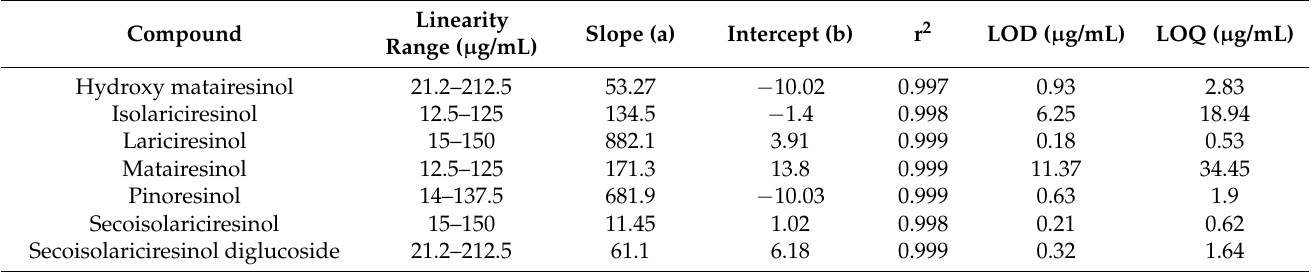
Table 2. Linearity and sensitivity data obtained from UPLC-MS/MS analysis of lignans reference standards a